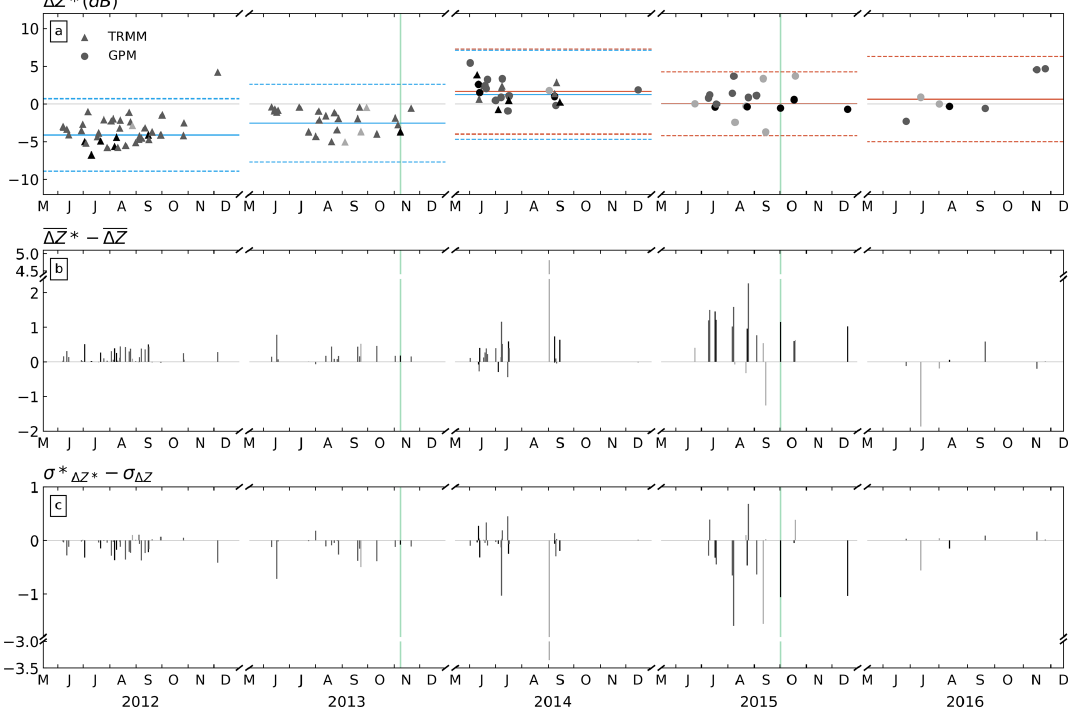
Figure 8. (a) Time series of the weighted mean bias ( (cid:49)Z ∗ ) from 2012 to 2016. Analysis covers only the wet season from June to December. Triangle markers represent TRMM overpasses, while circle markers are GPM overpasses. Symbols are coloured according to the number of volume-matched samples on a logarithmic scale: light grey: 10–99, medium grey: 100–999, and black: 1000+. Blue and orange solid (dashed) horizontal lines represent the weighted average (standard deviation) of all individual matched samples within the year for TRMM and GPM, respectively. (b) The difference between the weighted mean biases ( (cid:49)Z ∗ ) and the simple mean biases ( (cid:49)Z ). (c) The standard deviation of the weighted mean bias minus the standard deviation of the simple mean bias values. The green vertical lines indicate the dates of the two case